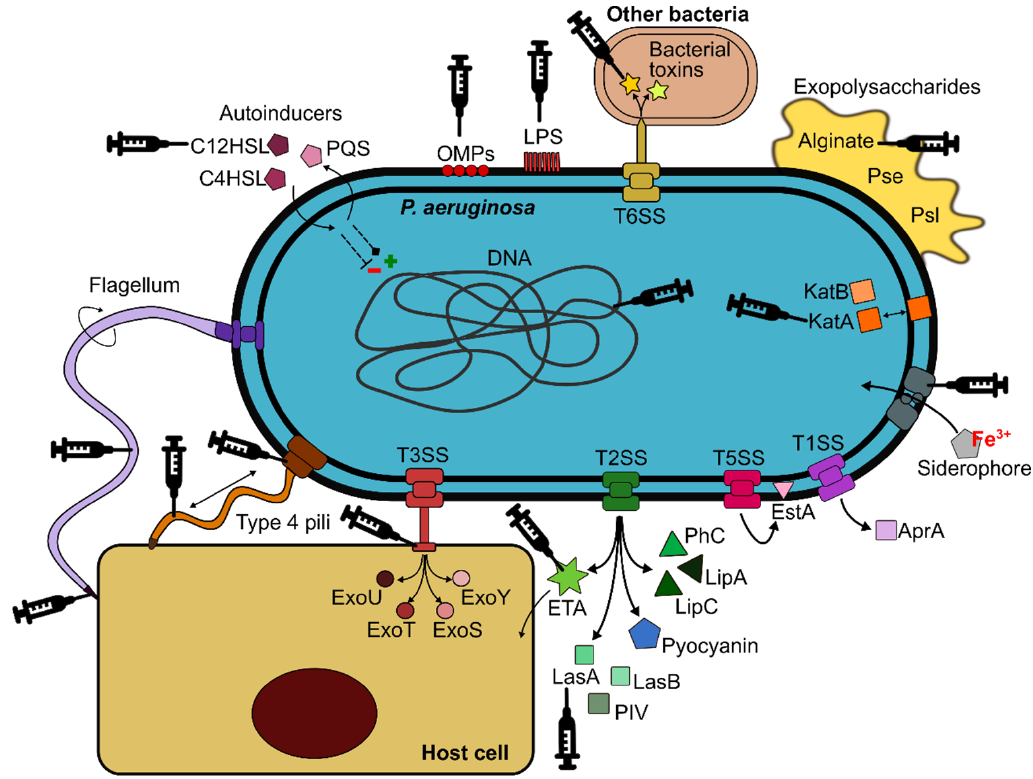
Figure 1. The main P. aeruginosa virulence factors involved in pathogenesis during pulmonary infections. The components highlighted with syringes have already been evaluated as vaccine antigens.